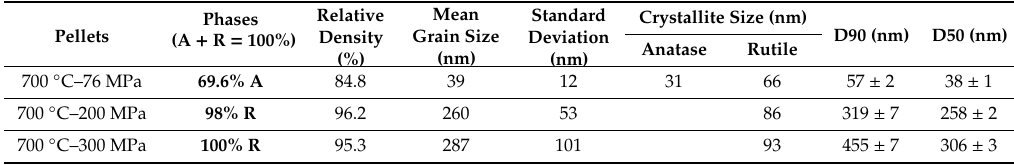
Table 1. Characteristics of the di ff erent pellets produced in this study. The heating rate is 100 ◦ C / min for all samples, except for the sample “850 ◦ C–76 MPa” which was heated at 10 ◦ C / min. The mean grain size and the corresponding standard deviation, D90 (90% of the particles are below this size), D50 (median) are evaluated from the SEM images. The crystallite sizes are extracted from the XRD patterns fitted using Fullprof Suite package